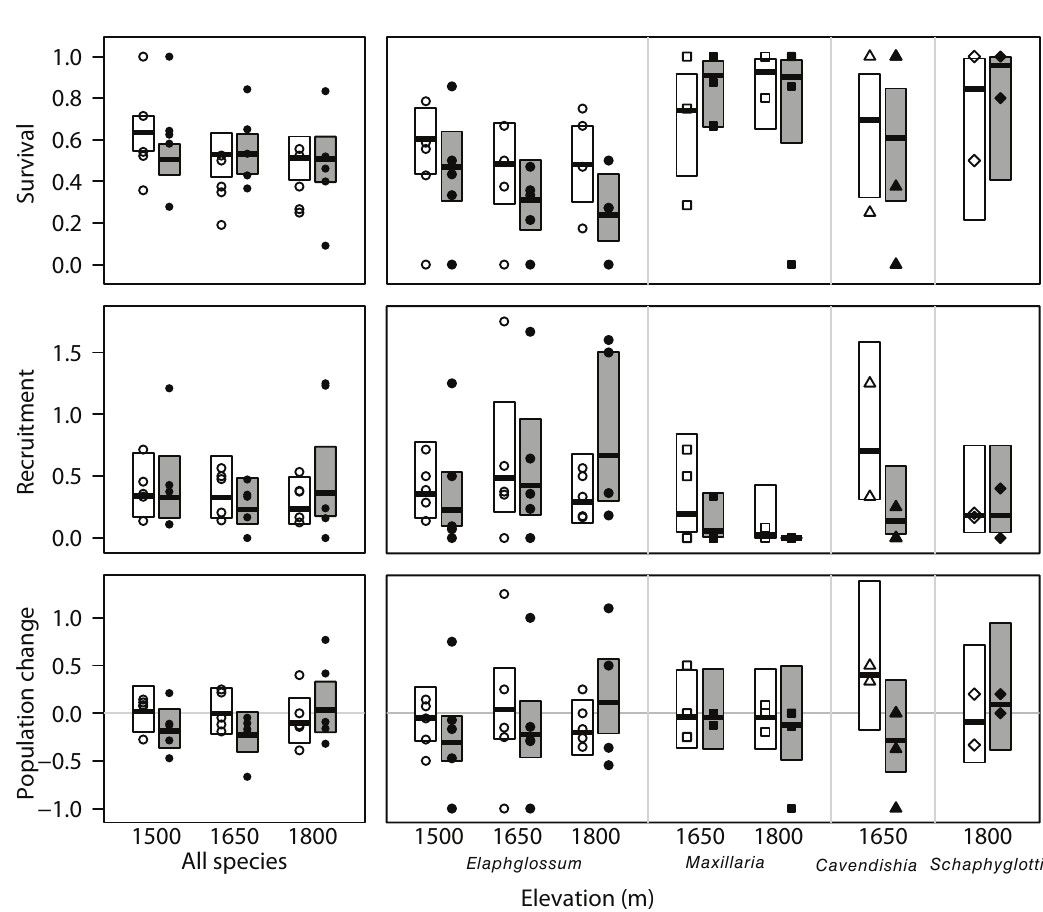
Figure 1. Survival, recruitment, and population change of ramets of all epiphyte species pooled and four abundant epiphyte species from a reciprocal transplant experiment within three elevations. Points show survival (top), recruitment (middle), and population change (bottom) of individual mats in 2006, each expressed as a proportion relative to the number of ramets present in 2005. Thick horizontal lines and boxes depict the modeled mean and 95% confidence intervals, respectively. White shading depicts controls, dark shading